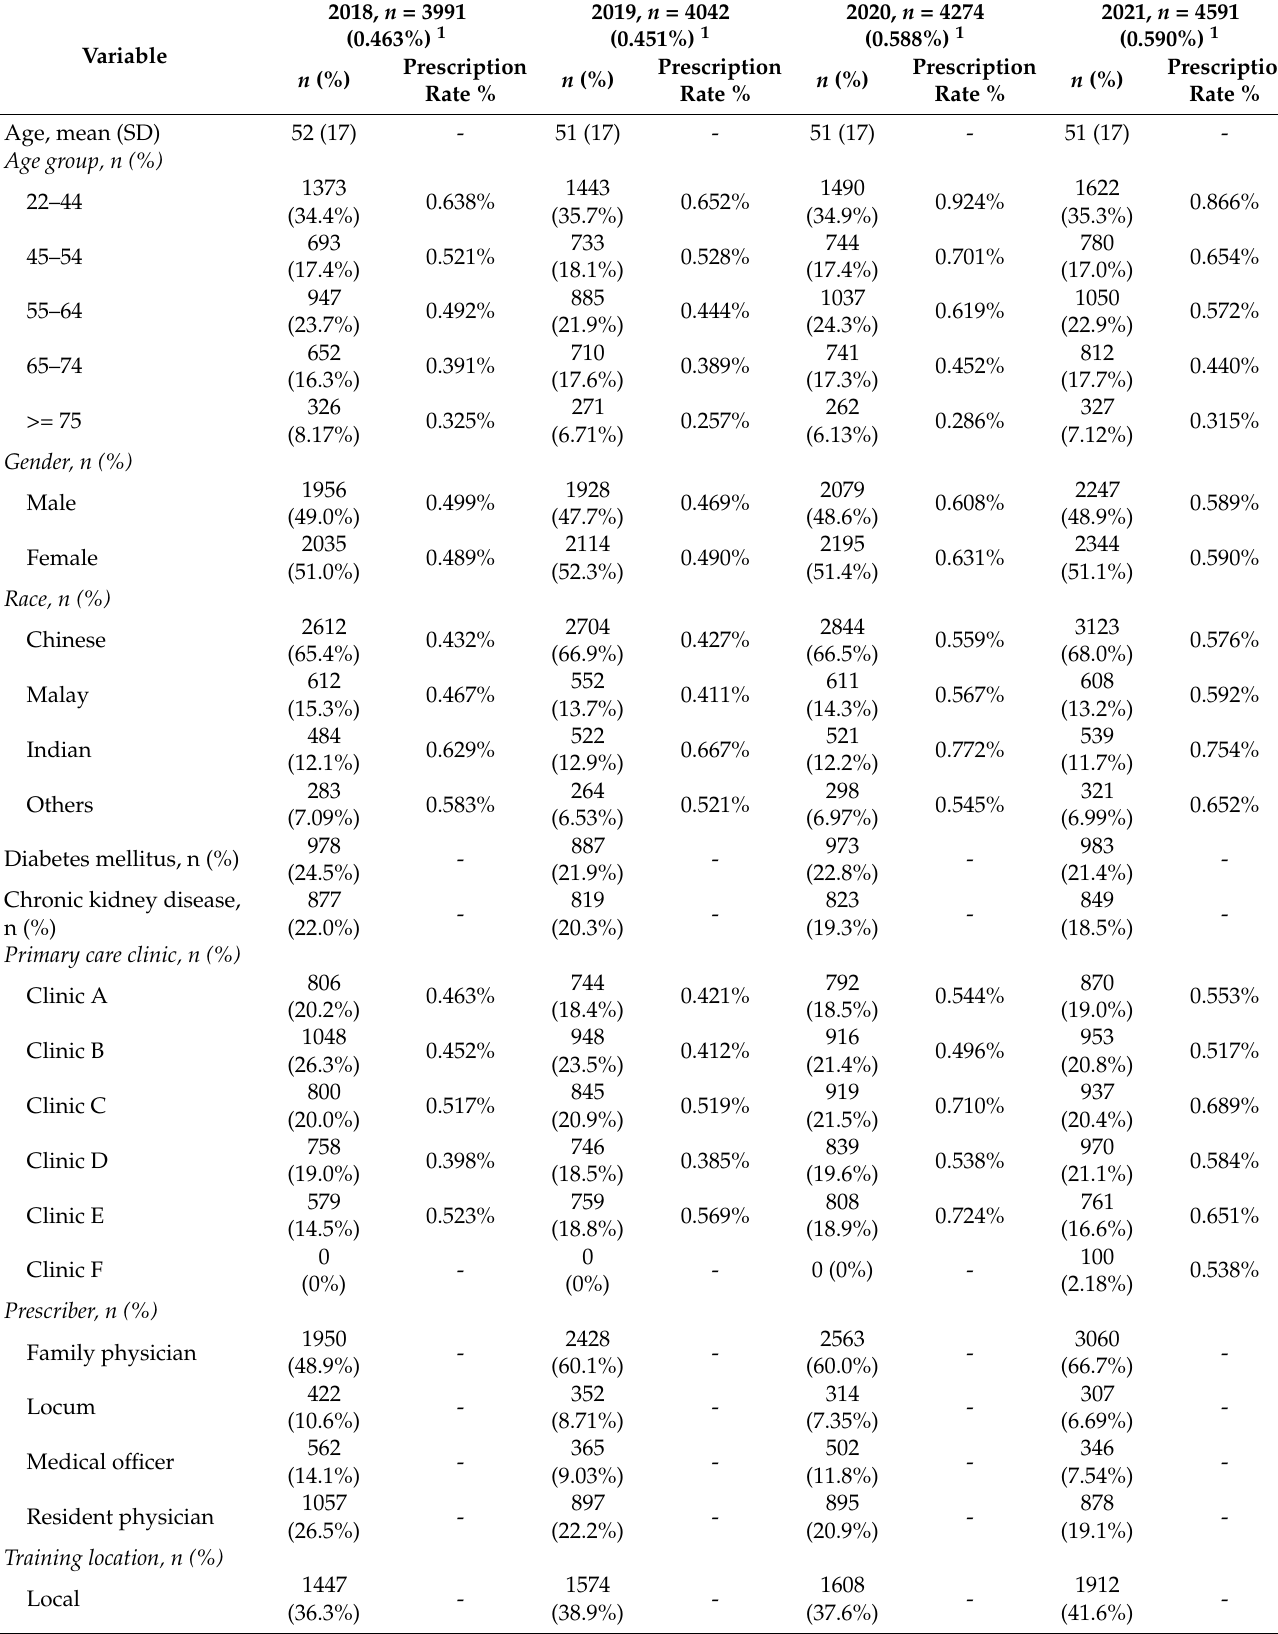
Table 3. Topical ENT antibiotic prescriptions,